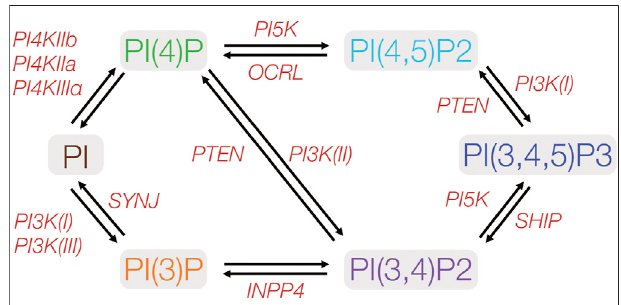
FIGURE 2 | Metabolic pathways of phosphoinositides implicated in cell polarity.PIsmaybephosphorylatedatanyofthethreehydroxylgroupsonthe inositol ring. Protein kinases and phosphatases involved in PIphosphorylation and dephosphorylation are indicated in red. PIxK- phosphoinositide x-kinase; OCRL- Inositol polyphosphate-5-phosphatase; SYNJ- phosphoinositide 5-phosphatase; INPP4- inositol polyphosphate-4- phosphatase; SHIP- Src homology 2 domain containing inositol polyphosphate 5-phosphatase. PTEN- phosphatase and tensin